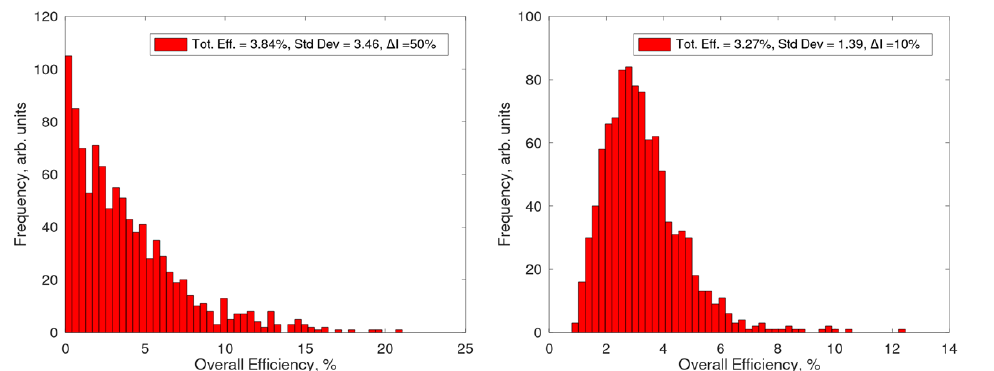
Figure 9. Total efficiency distribution obtained by the Monte Carlo simulation. Maximum fluctuation for ∆ I : 50% ( left ); 10% ( right